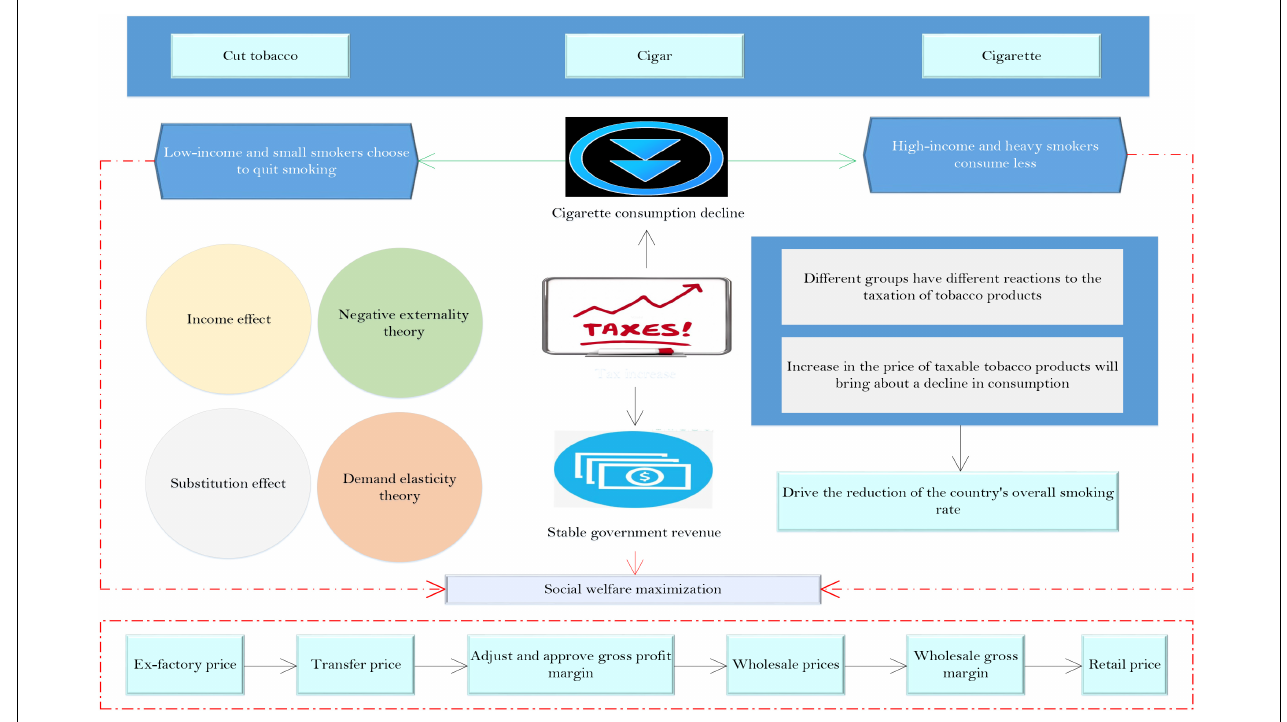
FIGURE 1 | Conceptual framework diagram of the impact of raising the tobacco excise tax on tobacco consumption and government revenue.